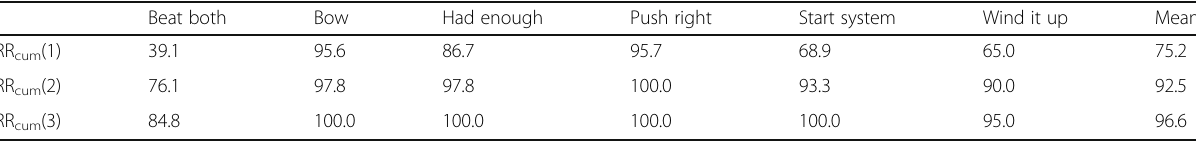
Table 7 Cumulative recognition rates for metaphoric gestures of MSRC-12 dataset Beat both Bow Had enough